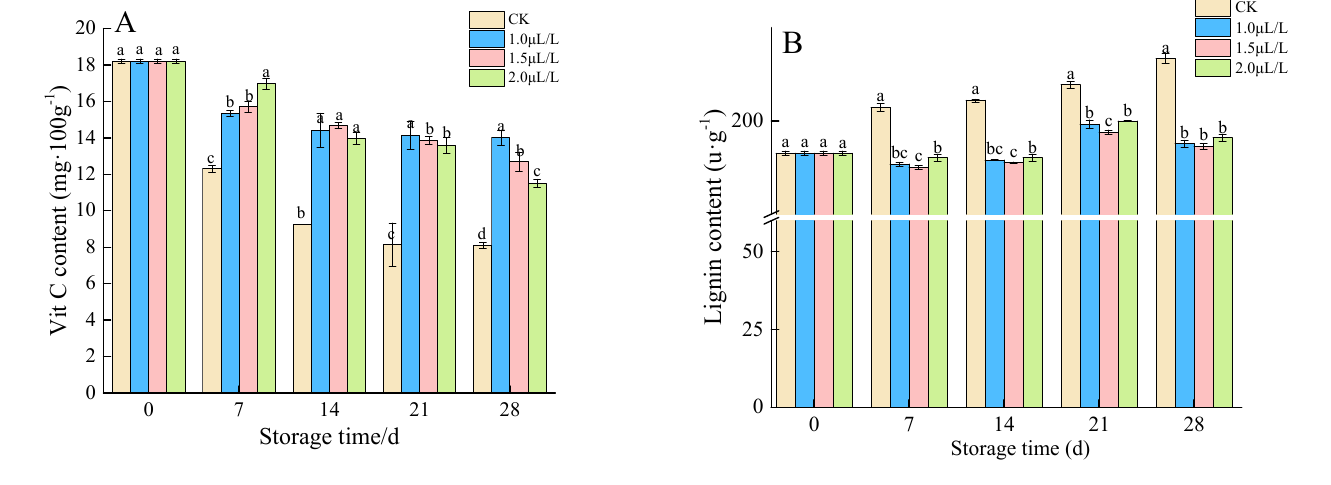
Figure 4. Effects of 1-MCP on Vit C content ( A ) and lignin content ( B ) of root mustard. Different letters at each time point indicated a significant difference between treatments ( p < 0.05) by Duncan’s multiple range test.